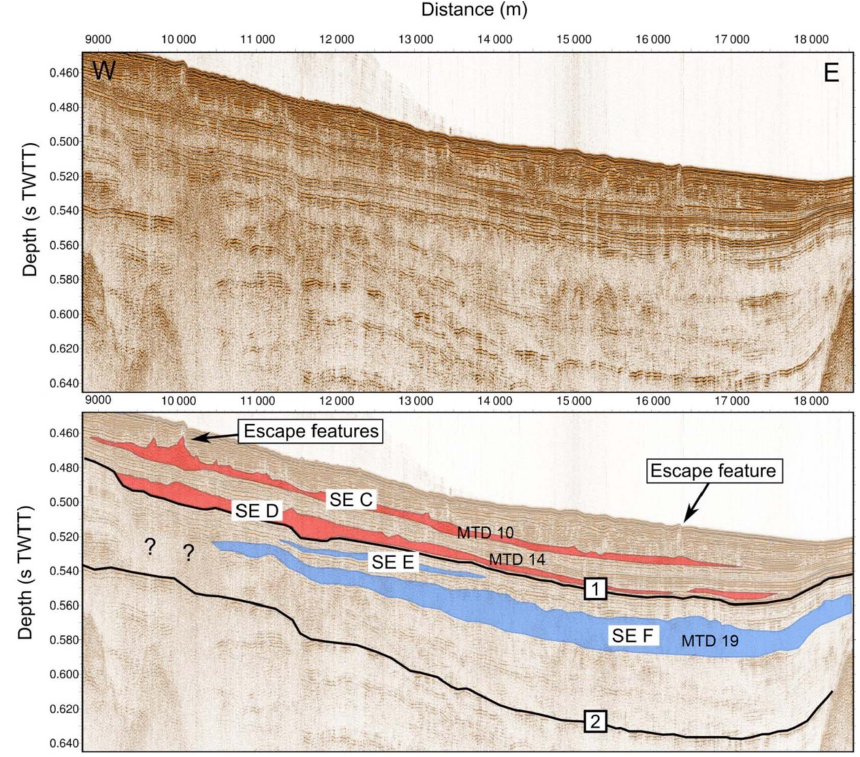
Figure 3. E–W sparker seismic profile showing the mass transport deposits imaged in the Delphic Plateau basin. See the location of the profile in Fig. 2. Horizon (1) indicates the beginning of the last post-glacial transgression, at 10.5–12.5ka, and horizon (2) is the marine isotopic stage 6 to 5 transgression, which occurred at ca. 130ka (Cotterill, 2006; Beckers et al., 2015,